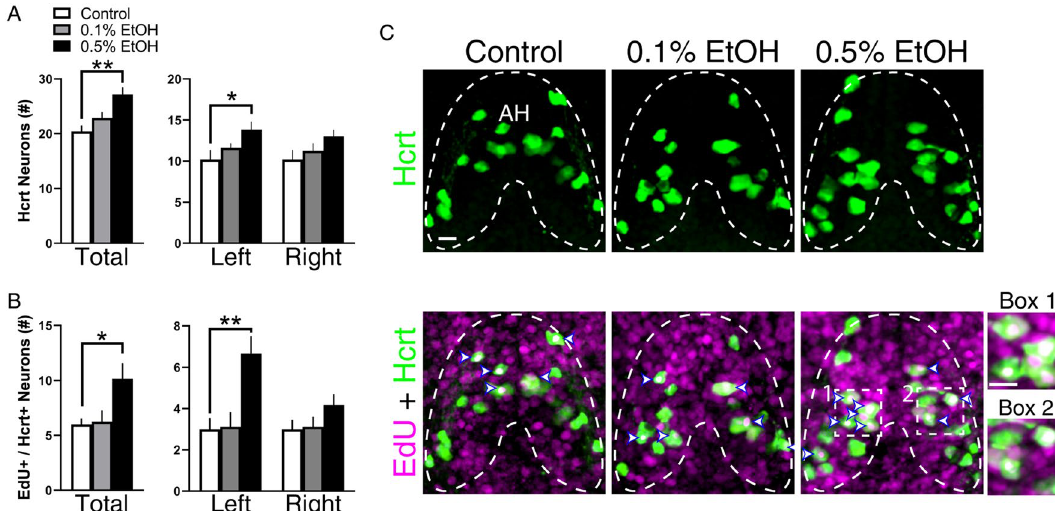
Figure 2. Effects of embryonic EtOH from 22 to 24 hpf on Hcrt neuron number and Hcrt proliferation in the AH measured using immunofluorescence and EdU labeling in 6 dpf larval zebrafish. ( A ) EtOH at 0.5% (n = 7) but not 0.1% (n = 8) significantly increases the total number of Hcrt neurons and the number of Hcrt neurons on the left but not right side of the brain compared to control (n = 5). ( B ) EtOH at 0.5% but not 0.1% increases the total number and left side number of Hcrt neurons labeled with EdU compared to control. ( C ) These effects are illustrated in representative confocal images with the AH outlined. They show that 0.5% but not 0.1% compared to control increases the total and left side number of GFP-positive Hcrt neurons (green in top row) and the total and left side number of EdU-labeled (magenta in bottom row) + GFP-positive Hcrt neurons (overlay, white in bottom row), with double-labeling neurons identified by white arrow heads outlined in blue with examples on the left and right enlarged within boxes 1 and 2, respectively. Scale bars, 10 µm. Results are shown as means ± standard errors. *p < 0.05, **p < 0.01. AH anterior